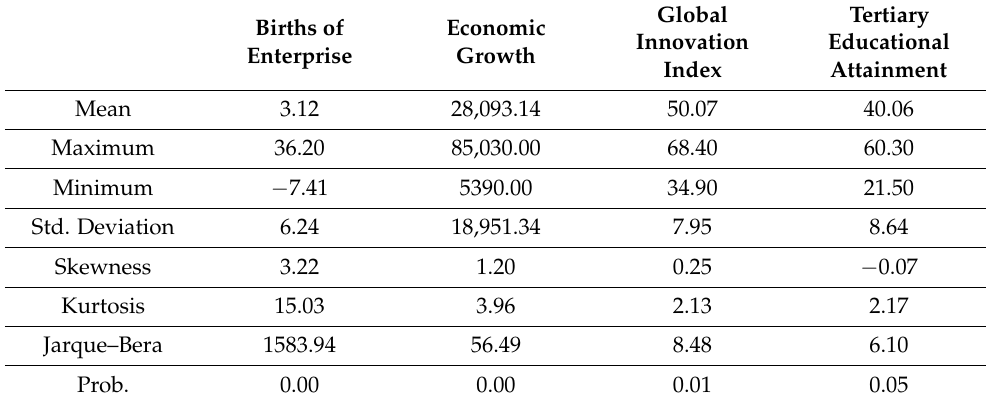
Table 2. Summary statistics.